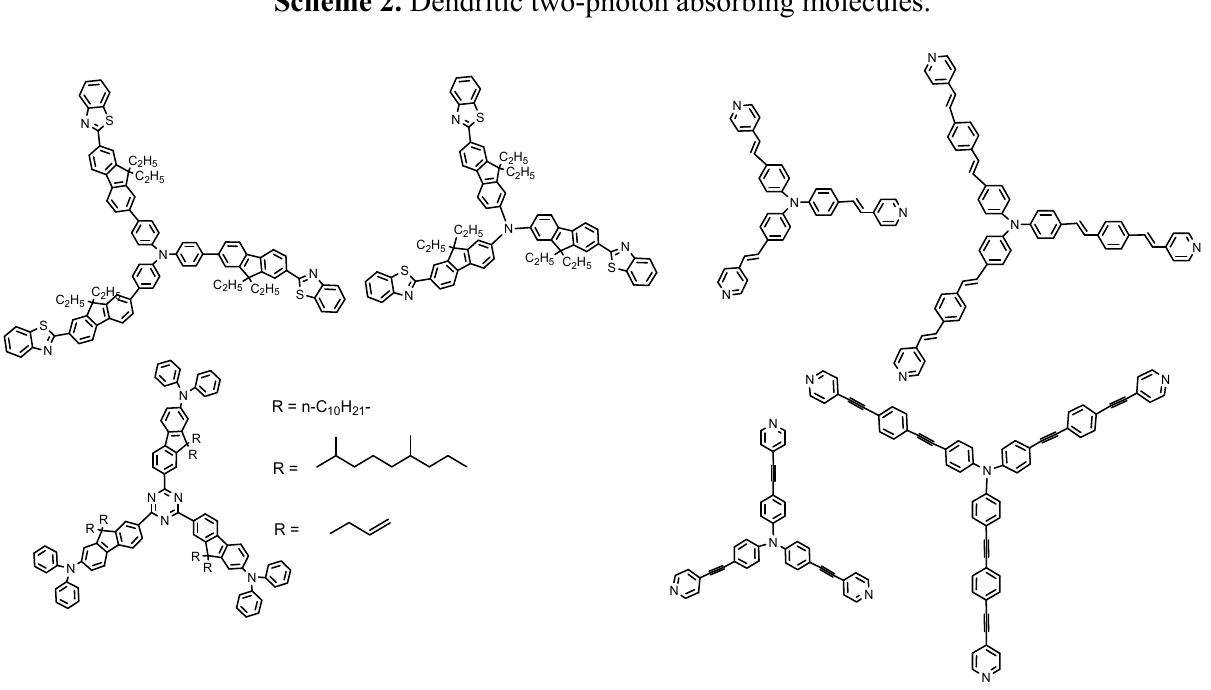
Scheme 2. Dendritic two-photon absorbing